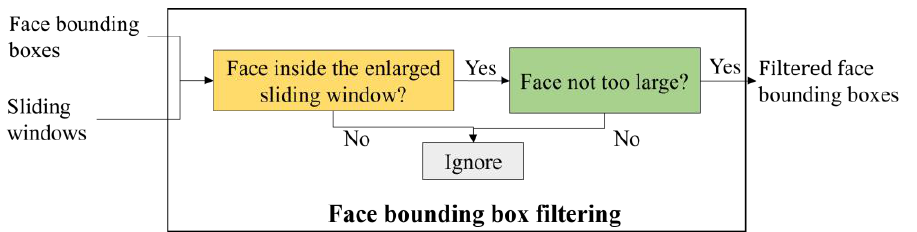
Figure 8. Diagram of the face bounding box filtering module.